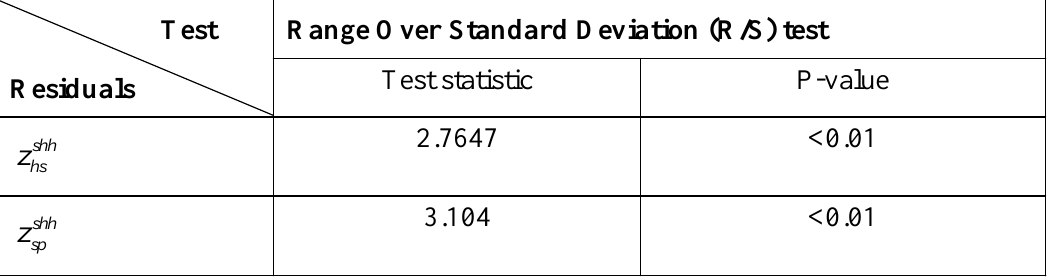
Table 4: Stationarity and long memory tests on cointegration residuals